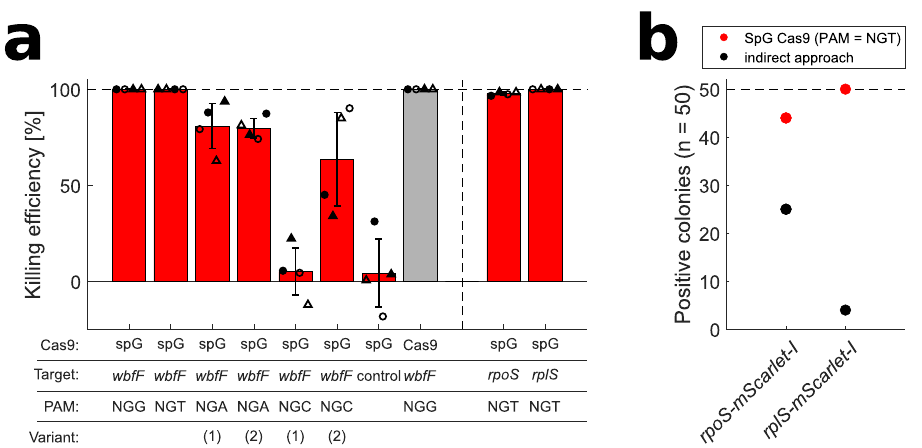
Fig. 5 Testing compatibility of near PAM less spG Cas9 in NT-CRISPR. a Killing ef fi ciency with spG Cas9 with all possible PAM sequences. Cas9 with NGG PAM is shown as a reference in gray. Killing ef fi ciency is calculated as follows: Killingefficiency ½ % (cid:2) ¼ 1 (cid:3) CFU = μ Lwithcounterselection replicates, representing two independent biological replicates (circle or triangle) and two independent experiments ( fi lled or open symbols). Bars show the mean of all replicates and error bars indicate standard deviation of the mean. The dashed line indicates the highest possible value. b Ef fi ciency for integration of mScarlet-I using either SpG Cas9 with a NGT PAM sequence or using the indirect approach described above. Integration of mScarlet-I was identi fi ed by PCR assays ( n = 50